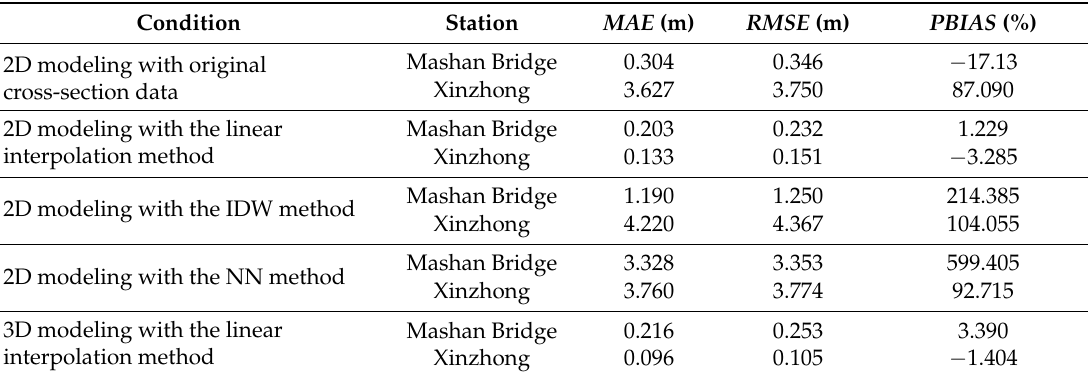
Table 2. Statistical error between the simulated and measured river stages under the high flow condition. Condition 2D modeling with